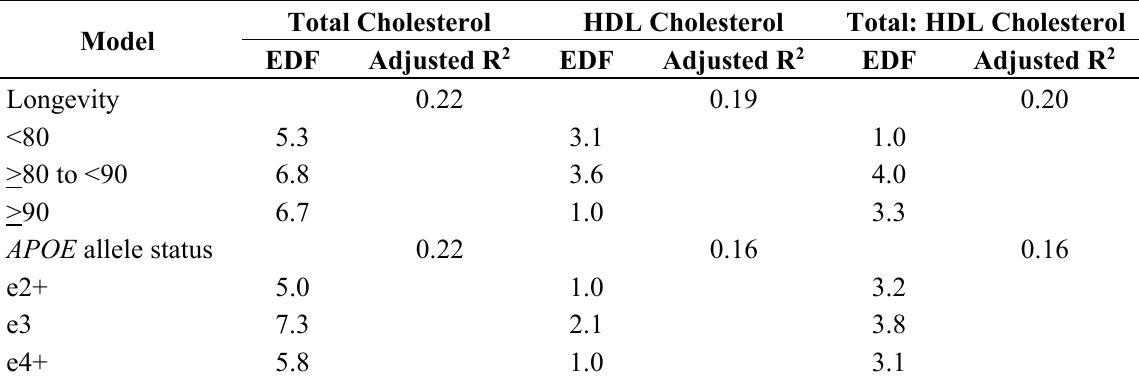
Table 6. EDF and adjusted R2 for trajectories of total, HDL, and total: HDL cholesterol ratio according to longevity, and APOE allele status among long-lived